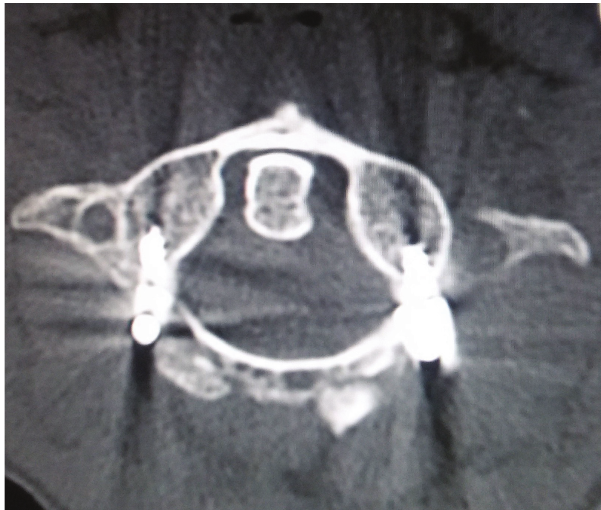
Figure 4. CT spine showing projection of screws through lateral mass of C1.